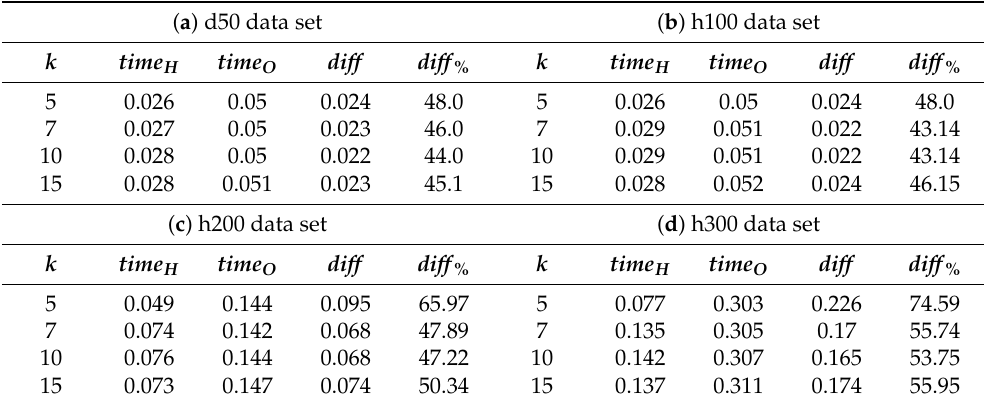
Table 2. Average run time in seconds on different data sets depending on the length of the k-mers in the case of fixed gap penalty.